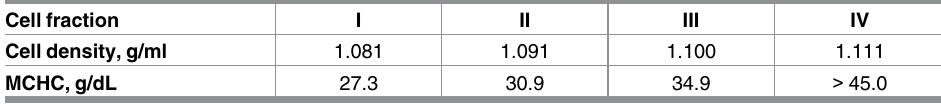
Table 2. Values of cell density and MCHC in different cell